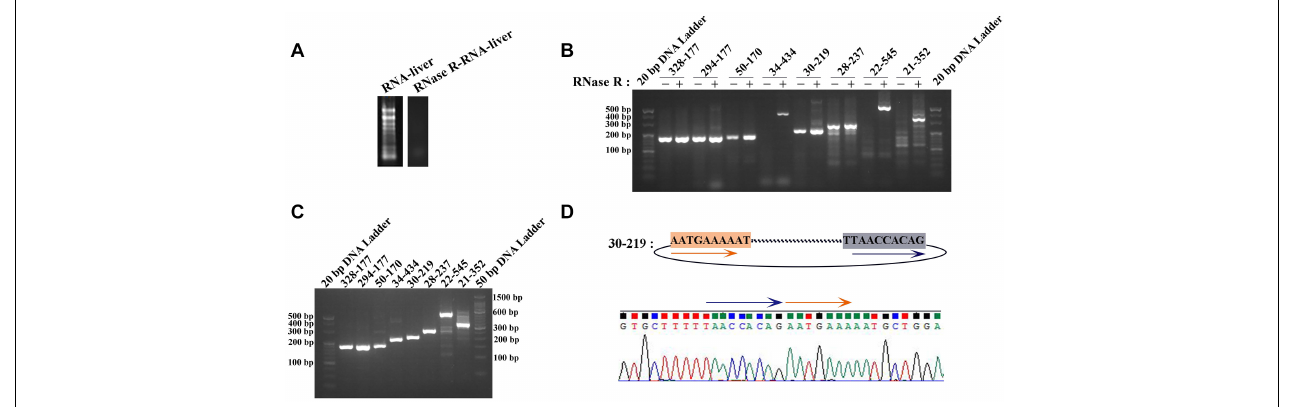
FIGURE 4 | Identification of circRNAs. (A) The total RNA was treated by RNase R. (B) The amplification result of RT-PCR using divergent PCR primers (“ + ” represents RNase R-treated RNA as the reverse transcription template, “ − ” represents the total RNA transcription). (C) Amplification result of RT-PCR using convergent PCR primers and RNase R-treated RNA as the reverse transcription template. (D) Sanger sequencing of 30-219 confirmed the back-splicing junction in PCR products.